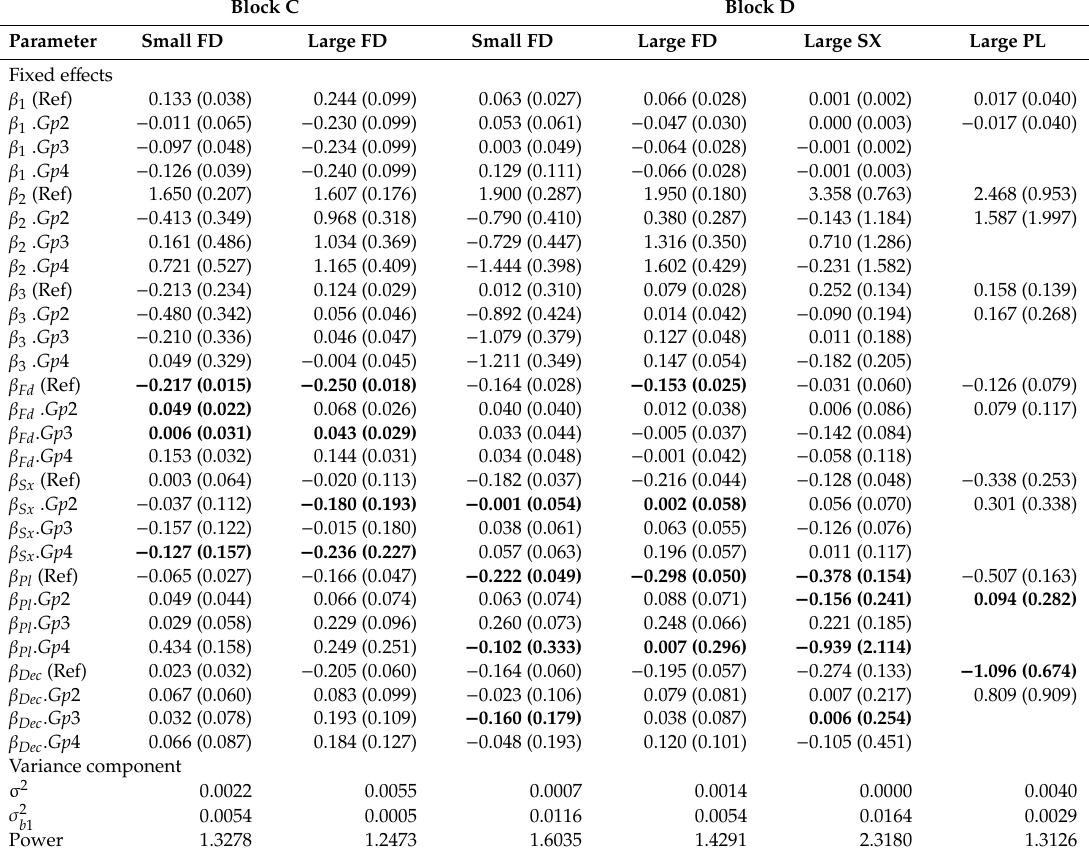
Table 5. Estimated parameters of the periodic annual basal area growth models (Equation (9)) for small (from 2.0 to 9.9 cm DBH in 1993) and large ( ≥ 10.0 cm DBH in 1993) interior Douglas-fir (FD), interior spruce (SX) and lodgepole pine (PL) in Blocks C and D, with partitioned competition index. β 1 (Ref), β 2 (Ref), and β 3 (Ref) are fixed-e ff ect parameters corresponding to the initial DBH and the first growth period; β Fd (Ref), β Sx (Ref), β Pl (Ref), and β Dec ( Ref ) are fixed e ff ect parameters corresponding to the competition impacts of each competitor species and the first growth period. Each of these coe ffi cients are varied by the 2 nd , 3 rd , and 4 th growth periods ( Gp 2, Gp 3, and Gp 4 (most negative values bolded); σ 2 is the residual variance; σ 2 is the plot random e ff ect variance; standard errors are b 1 given in